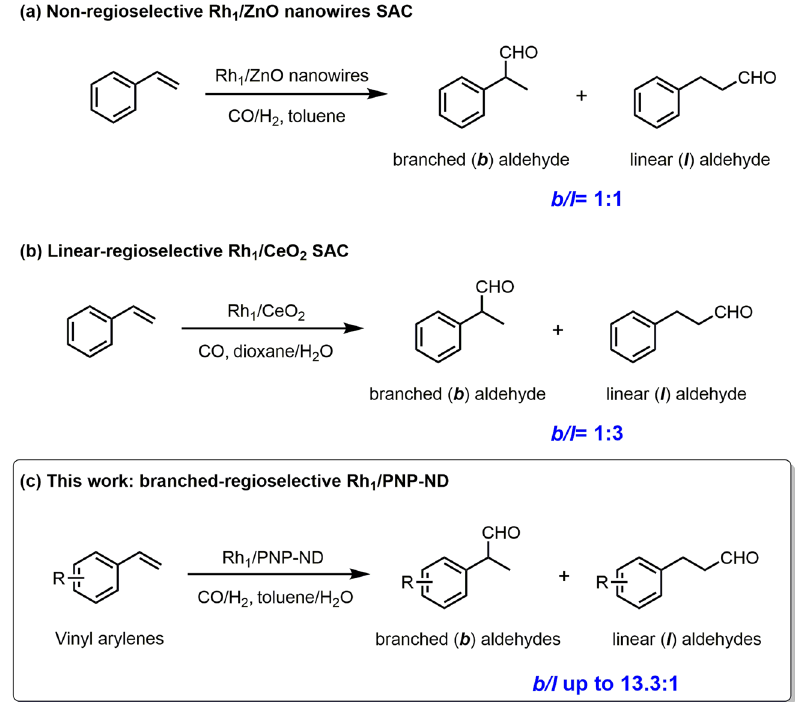
Fig. 1 Rh single atom catalysts for regioselective hydroformylation of vinyl arylenes. a Rh 1 /ZnO nanowires SAC. b Rh 1 /CeO 2 SAC. c the present Rh 1 / PNP-ND